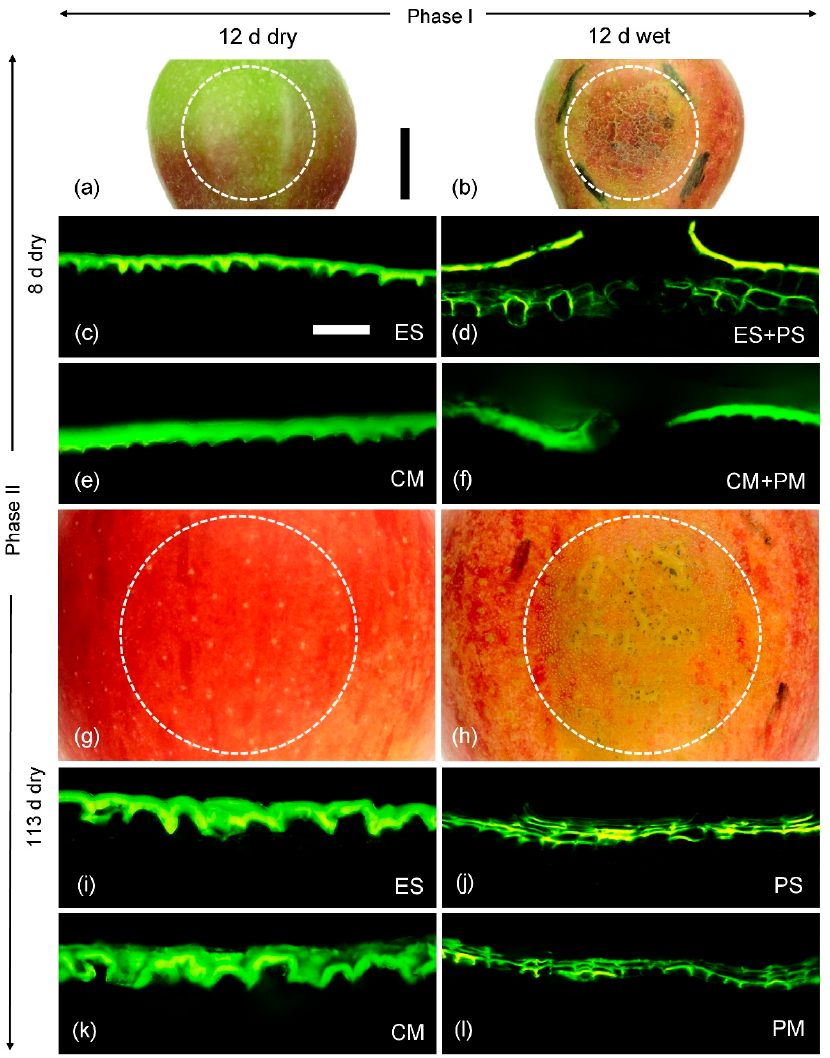
Figure 5. Macroscopic view of unexposed control patches ( a , g ) and moisture exposed ( b , h ) skin patches of apple fruit. Cross-sections of epidermal skin samples (ES) of control patches ( c , i ) and of the composite skins of moisture-exposed patches comprising epidermal plus peridermal sections (ES+PS) ( d ) or peridermal section only (PS) ( j ). Cross-sections of isolated cuticular membranes (CM) ( e , k ) and cuticular plus periderm membranes (CM+PM) ( f ) or periderm membranes only (PM) ( l ). The moisture treatment was applied as a two-phase experiment. During Phase I, a patch of the fruit skin was exposed to moisture for 12 d beginning at 31 days after full bloom (DAFB) (wet). During the subsequent Phase II moisture was removed, and the patch was exposed to the atmosphere (dry) ( b,d , f , h , j , l ). A portion of the unexposed surface on the same fruit served as control ( a , c , e , g , i , k ). Micrographs were taken 8 d ( a – f ) and 113 d ( g – l ) after moisture exposure was discontinued. Images in ( c – f ) and ( i – l ) were taken under incident fluorescent light (U-MWB) after staining with Fluorol Yellow 088. The scale bar in ( a ) equals 10 mm and is representative for all surface views ( a , b , g , h ). The scale bar in ( c ) equals 50 µm and is representative for all cross-sections of the composite ( c – f , i – l ). The dotted circles in ( b ) and ( h ) mark the original footprint of the tube that was mounted on the fruit surface to enable moisture exposure, the dotted circles in ( a ) and ( g ) are unexposed control patches on the same fruit. For details of the moisture treatment, see Materials and Methods.